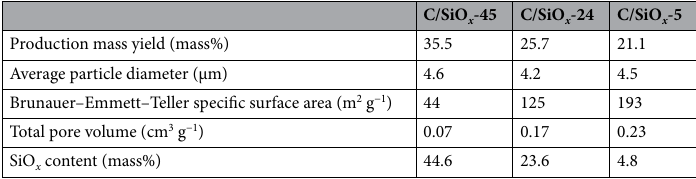
Table 1. Physical properties of the C/SiO x active materials.